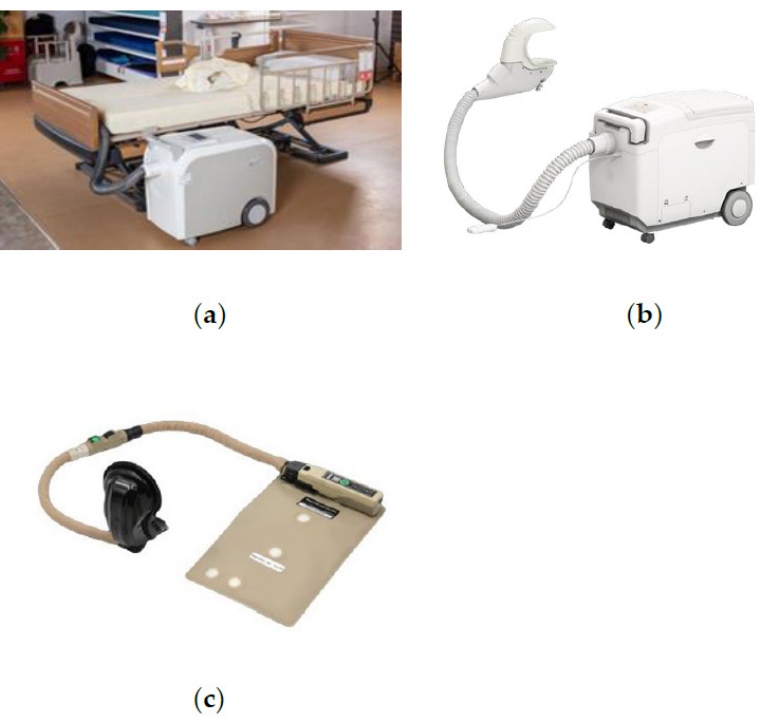
Figure 1. ( a ) Smilet automatic excretion processing robot; ( b ) Illinois Nursing Robot; ( c ) AMXDmax Urine collecting device [3].